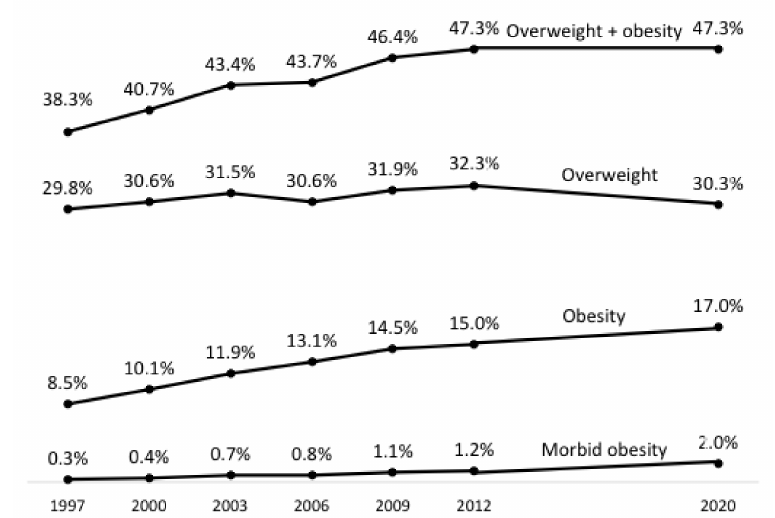
Figure 3. Position of LCO 2020 Obepi-Roche estimates of overweight and/or obesity compared to the Obepi studies 1997–2012 [8]. Overweight: 25 kg/m 2 ≤ BMI < 30 kg/m 2 ; obesity: BMI ≥ 30 kg/m 2 ; severe and complex (“morbid”) obesity: BMI ≥ 40 kg/m 2 .